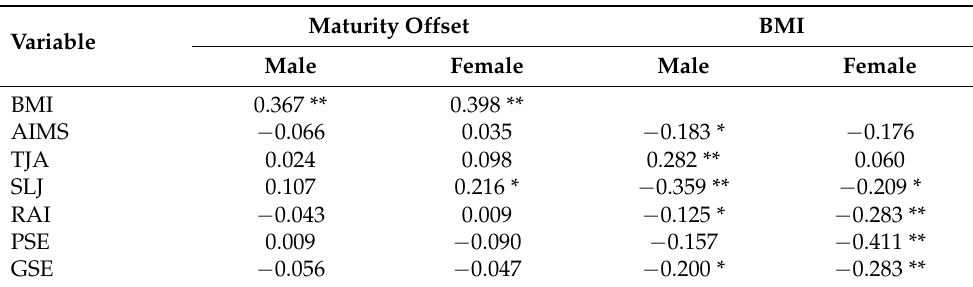
Table 5. Spearman’s Rho correlations between body mass index, maturity offset, athletic motor skill competencies, and psychological